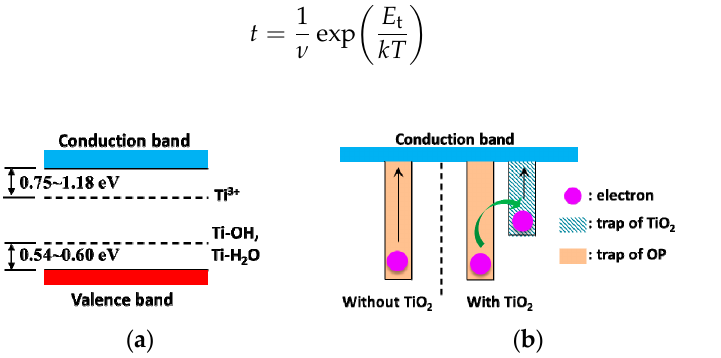
Figure 8. Schematic diagram of electric band structure and electron movement: ( a ) Band structure of anatase TiO 2 with oxygen vacancy; ( b ) schematic diagram illustrating process of electron escape.